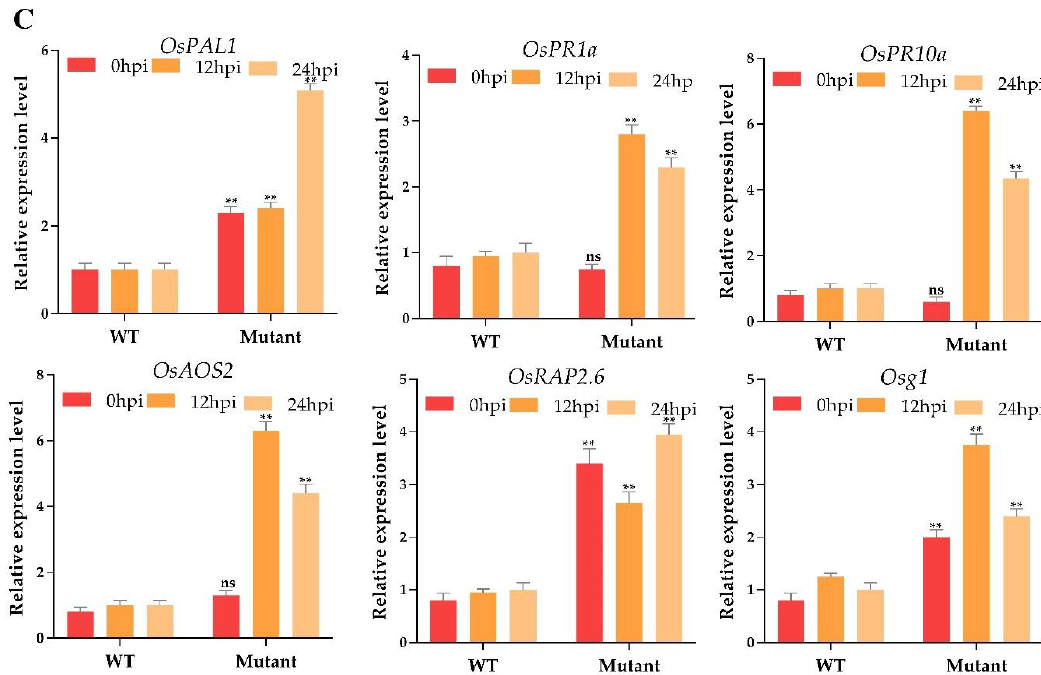
Figure 8. RT-qPCR results for target genes and proteomic data. ( A ) Pi21 and ( B ) eight selected DEPs responsive genes. ( C ) Relative expression of defense-response genes in WT and the homozygous mutant line inoculated with M. coryza . hpi; hours post-inoculation. “*” denotes the significant di ff erence, p ≤ 0.05 and “**” denotes the significant di ff erence, student’s t -test, p ≤ 0.01, n = 3.